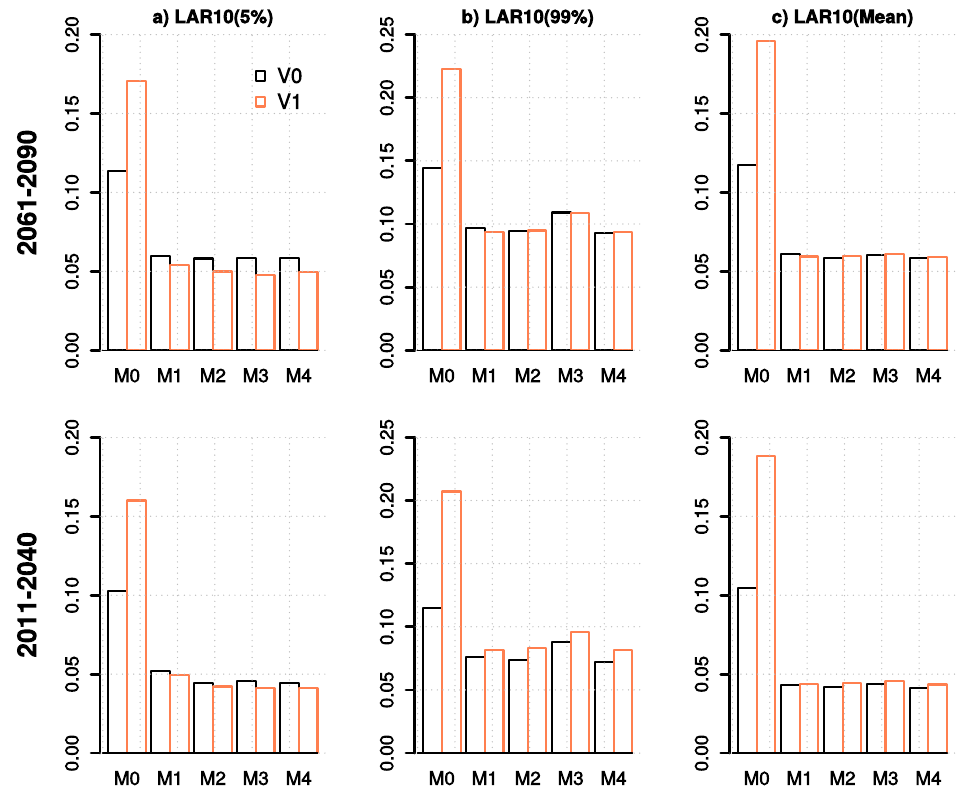
Figure 7. Similar to Figure 5 but for the cross-validated LAR10 in ( a ) the 5th and ( b ) 99th percentile of flow duration curves shown together with ( c ) the distribution-averaged LAR10 in years 2011–2040 ( bottom ) and 2061–2090 ( top